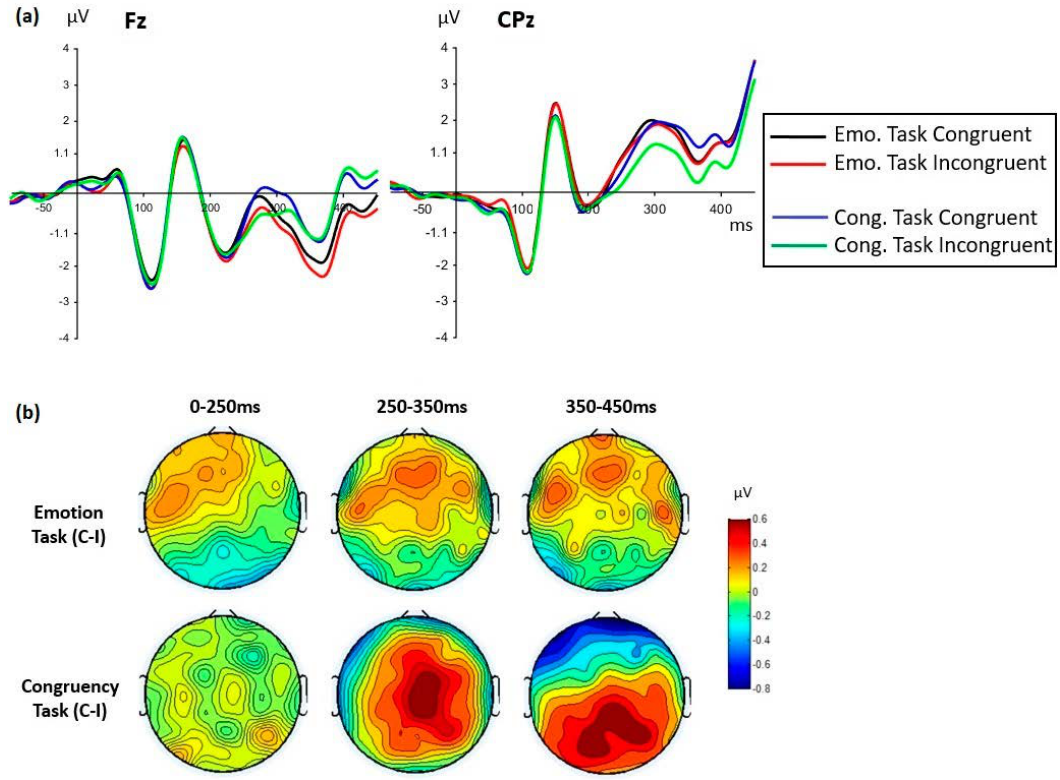
Figure 6. The effect of congruency varied with task. ( a ): group grand averaged waveforms for each task and congruency condition displayed at Fz and CPz sites. ( b ): topographic maps representing the congruency effect (congruent minus incongruent conditions) displayed for each task between face onset (0 ms) and 450 ms. The congruency effect was strongest in the congruency task, with a clear fronto-central then centro-parietal distribution (with polarity reversal at fronto-polar sites), and was clearly weaker and frontally distributed in the emotion task.